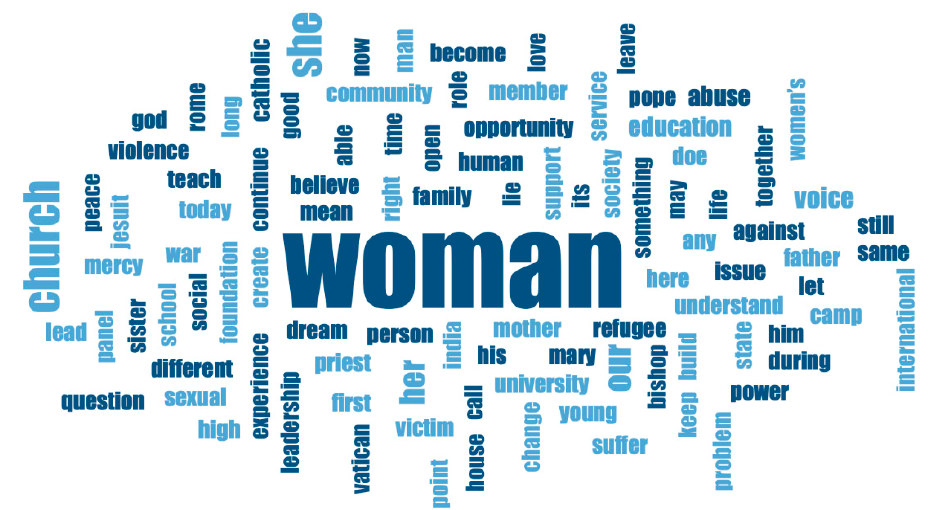
Figure 1. Word cloud of the yearly magazine Voices . (Source: authors’ elaboration, MAXQDA (edited stop-word list).